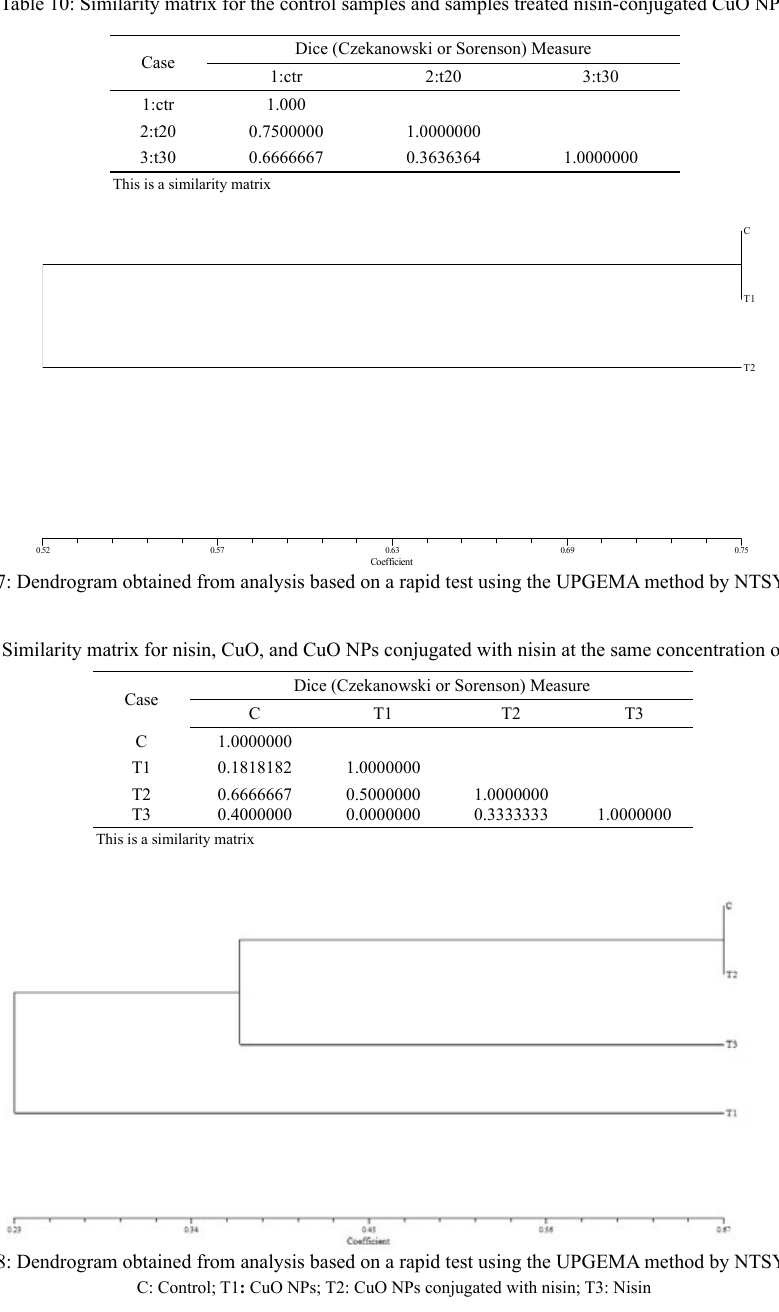
Table 10: Similarity matrix for the control samples and samples treated nisin-conjugated CuO NPs